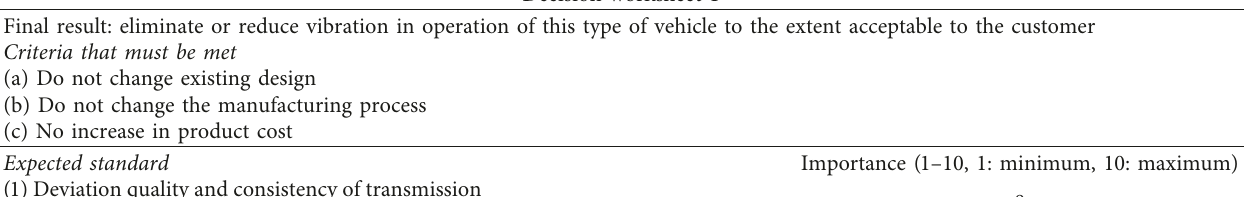
Table 7: Decision worksheet on permanent corrective measures. Decision worksheet 1